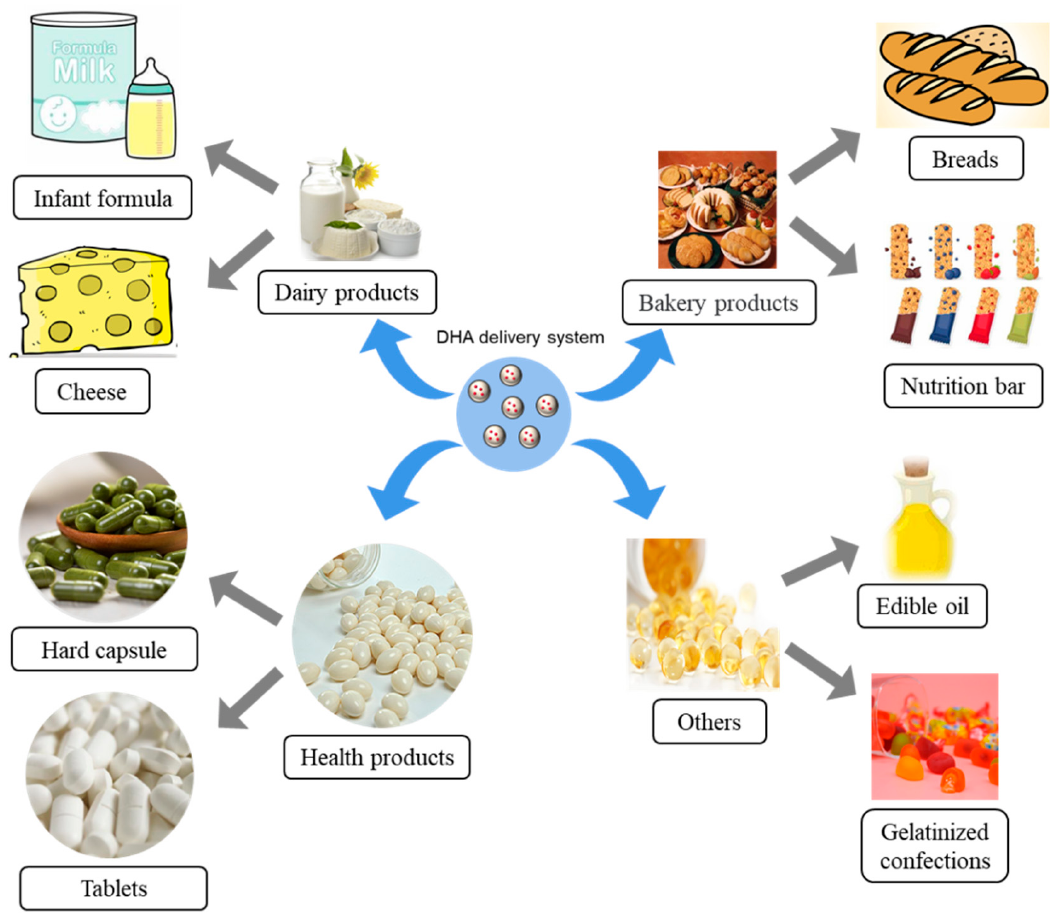
Figure 6. Food applications of DHA delivery systems.